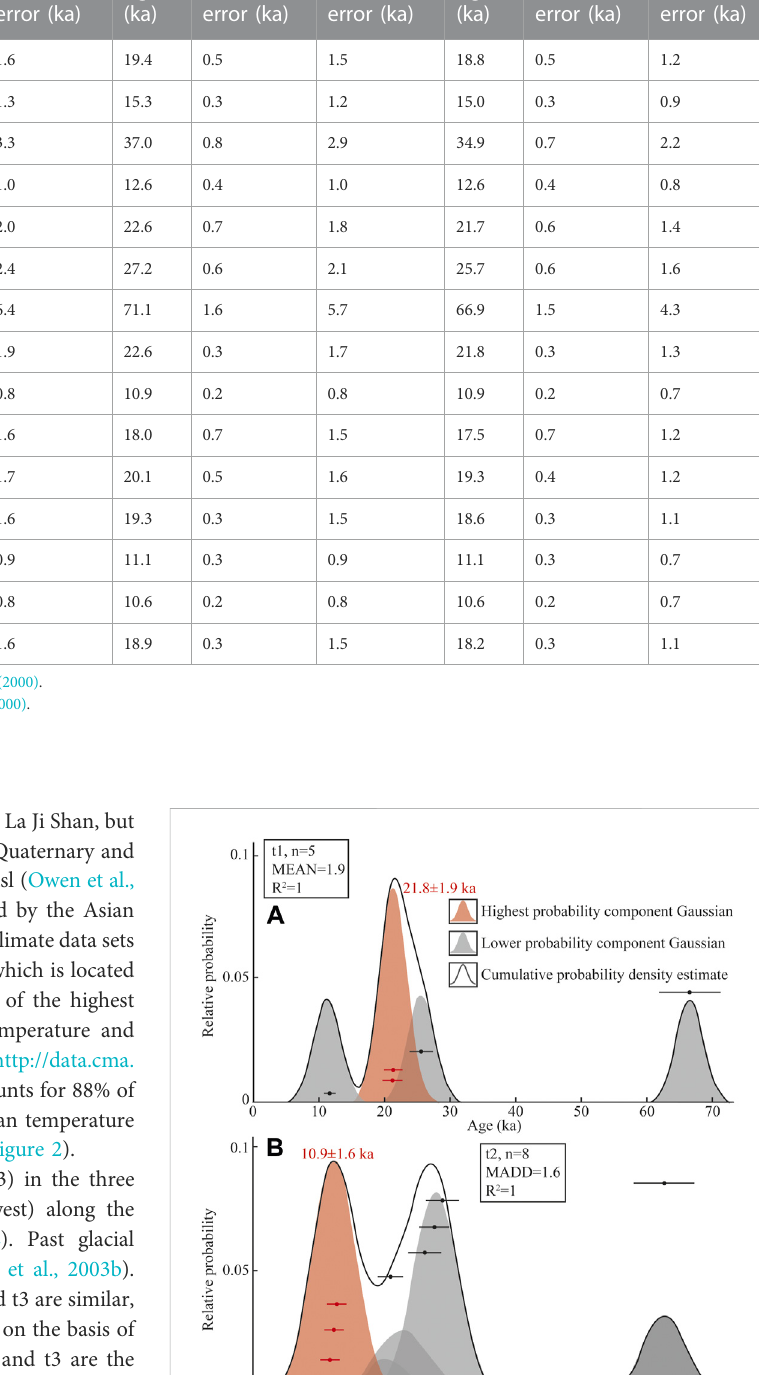
TABLE 1 Recalculated 10 Be exposure ages (Owen et al., 2003b) for the La Ji Shan. Moraine name